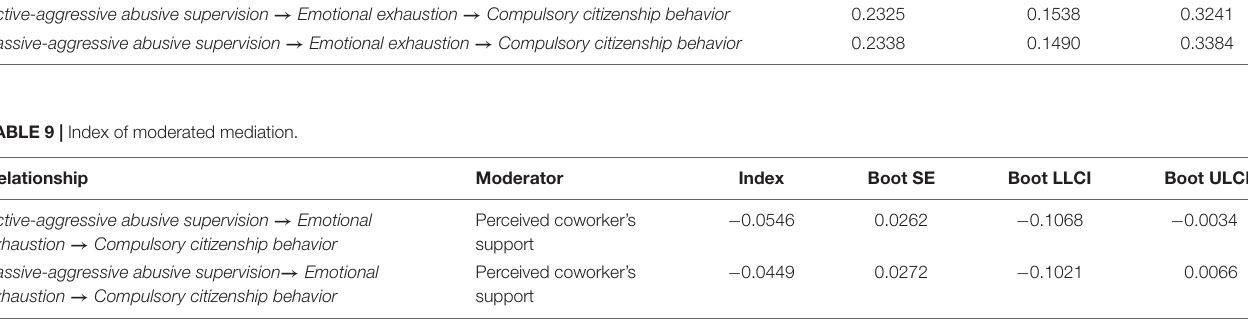
TABLE 8 | Mediation results with indirect effects. Relationship